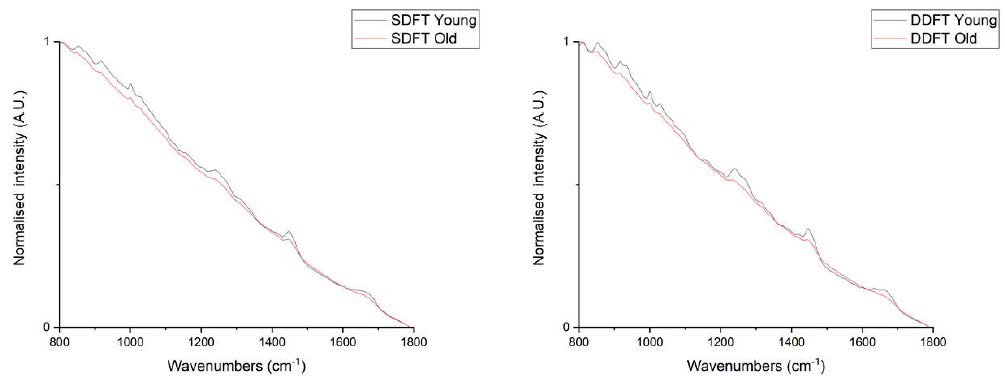
Figure 2. Averaged spectra after min–max normalised charge-coupled device (CCD) counts of young and old group in SDFTs ( Left , young:old = 40:30 spectra) and DDFTs ( Right , 40 spectra in both groups).